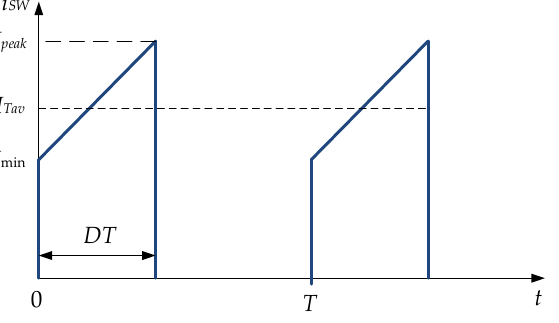
Figure 6. The current shape of a transistor in a DC – DC hard-switching converter.